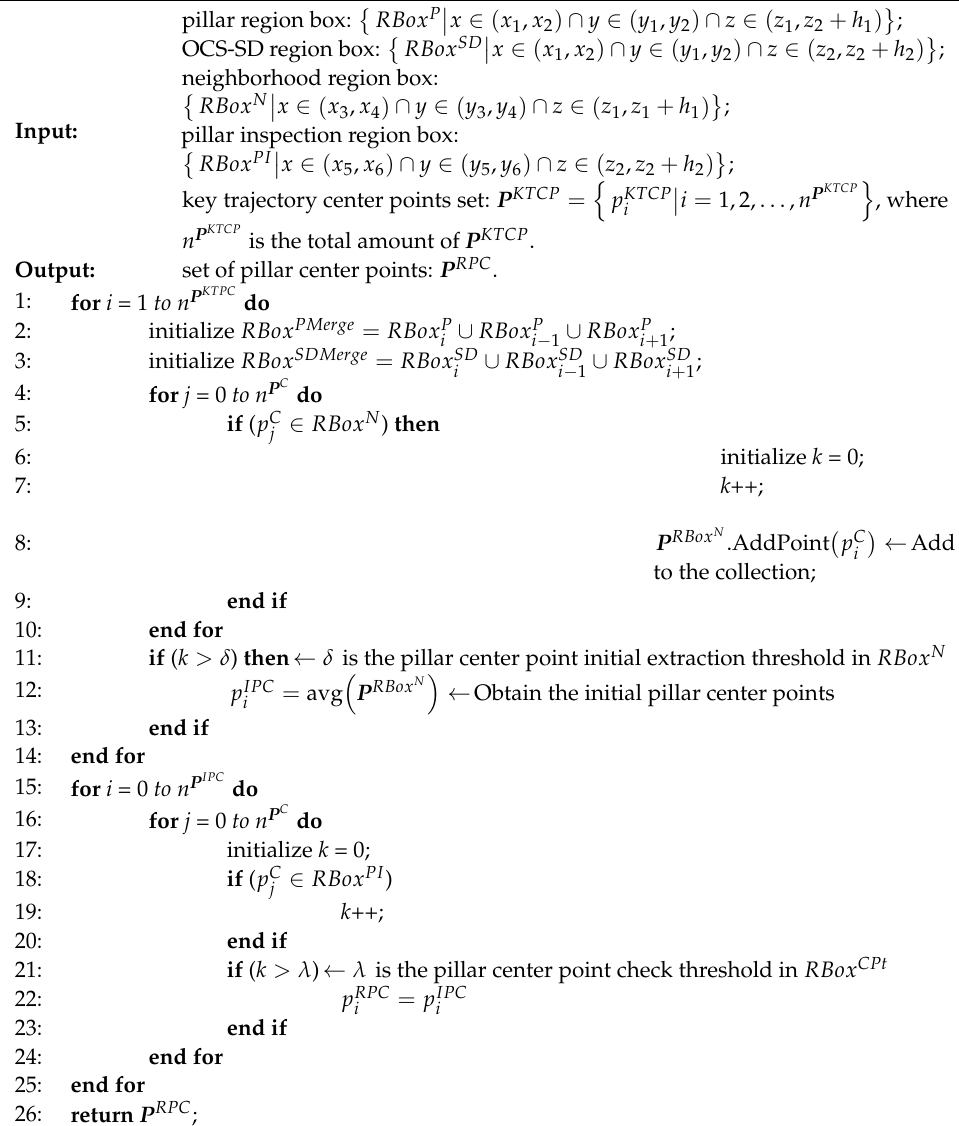
Algorithm 1. Algorithm for extracting pillar center